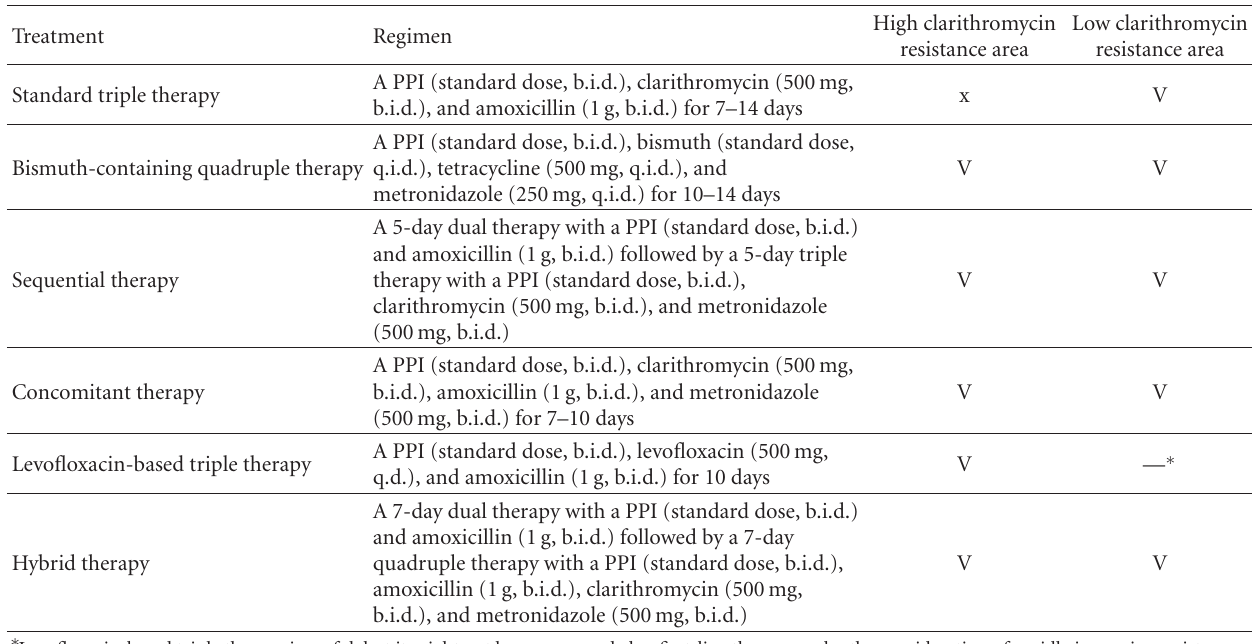
Table 1: Recommended first-line therapies for Helicobacter pylori